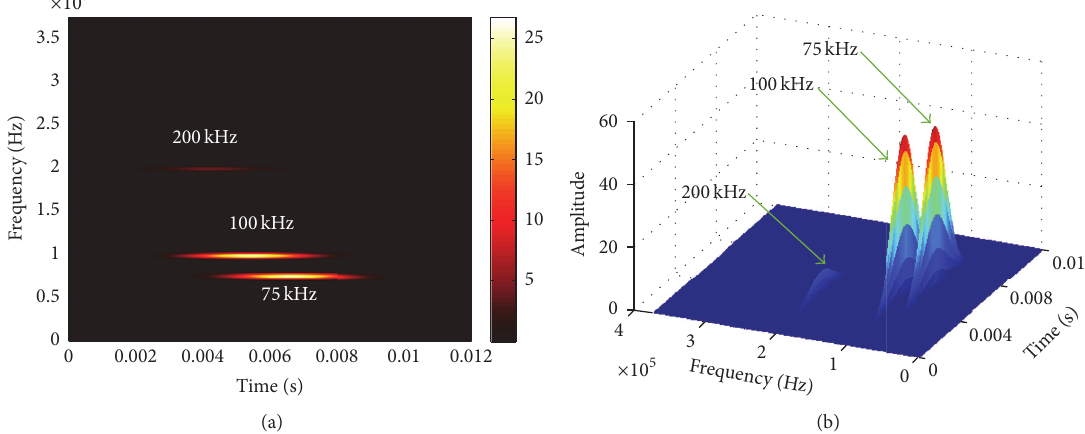
Figure 3: The SPWVD representation of the sample signal: (a) two-dimensional figure and (b) three-dimensional figure.